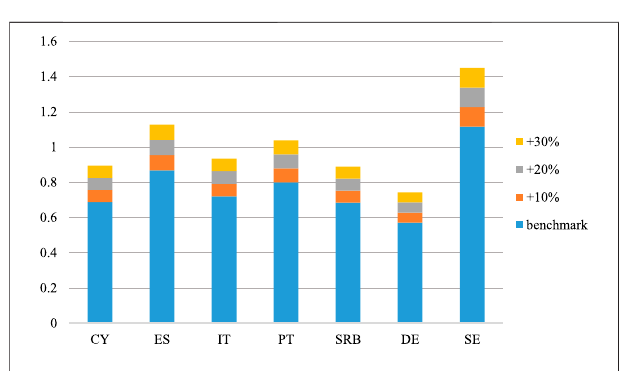
FIGURE 6 | Percentage ratio of GSHP systems to ASHP for various increments in ASHP ef fi ciency (COP), for the GWP impact per FU.